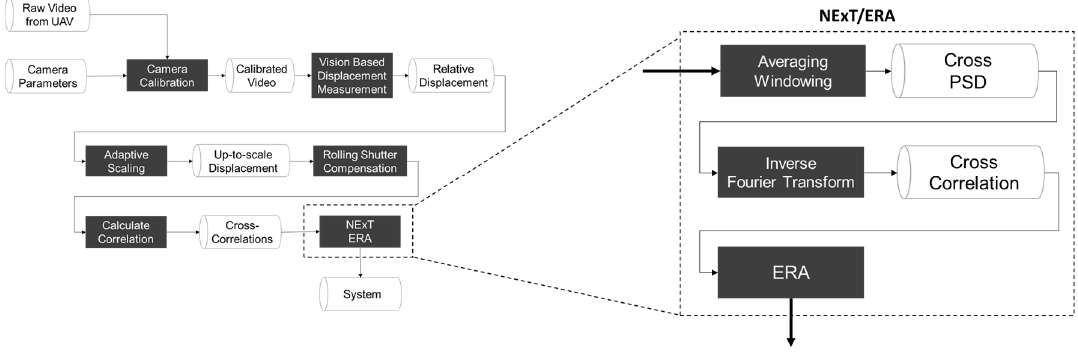
Figure 4. Flowchart for natural excitation technique (NExT)/eigensystem realization algorithm (ERA).